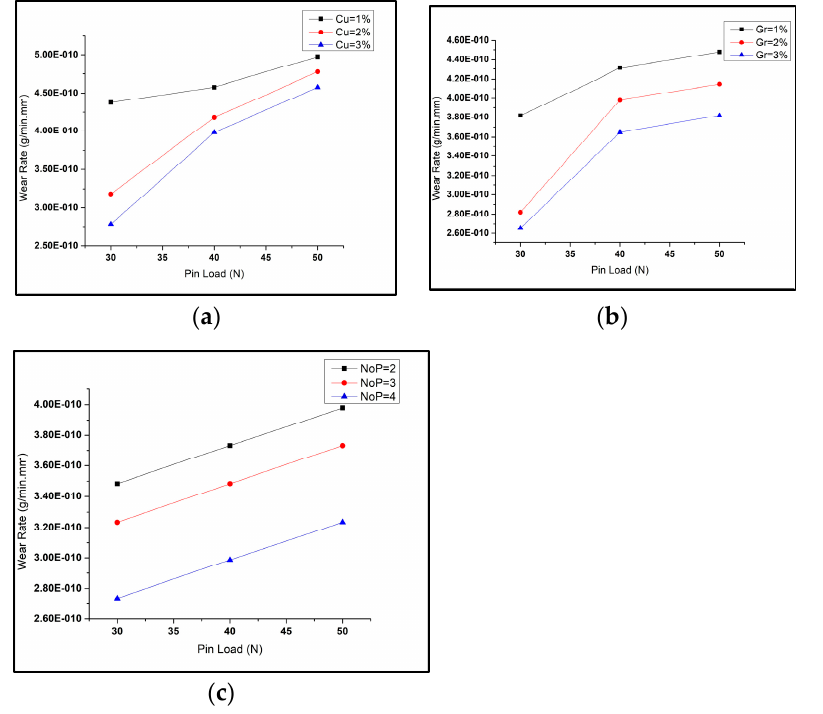
Figure 5. ( a ) Wear rate with varying pin load for different Cu% at 500 rpm; ( b ) wear rates with varying pin load for different Gr% at 600 rpm; ( c ) wear rate with varying pin load for different number of FSP passes.